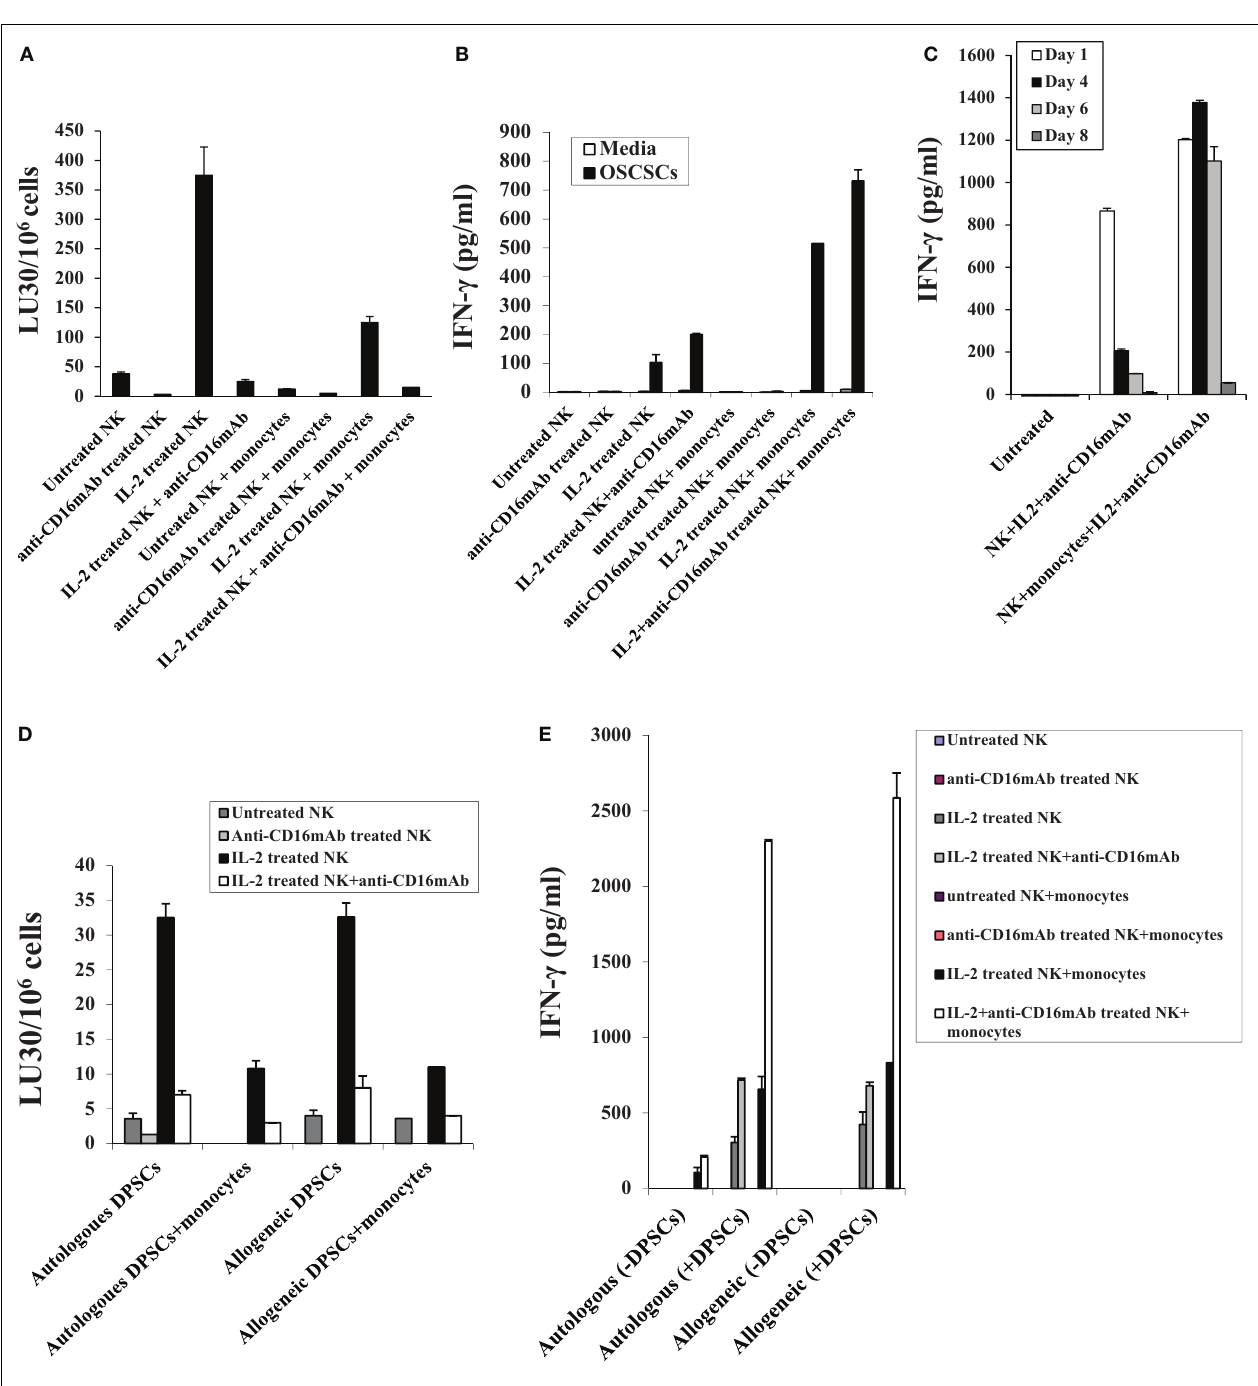
lytic units 30/10 6 cells were determined using inverse number of NK cells required to lyse 30% of the tumor cells × 100 (A) . NK cells were treated as described in Figure 2A and either cultured in the absence or presence of OSCSCs. After an overnight incubation, supernatants were removed from co-cultures and the levels of IFN- γ secretion were determined using specific ELISAs (B) . Highly purified NK cells were left untreated or treated as described in Figure 2A . After 1, 4, 6, and 8days post-treatment, supernatants were removed from NK cell cultures and the levels of IFN-